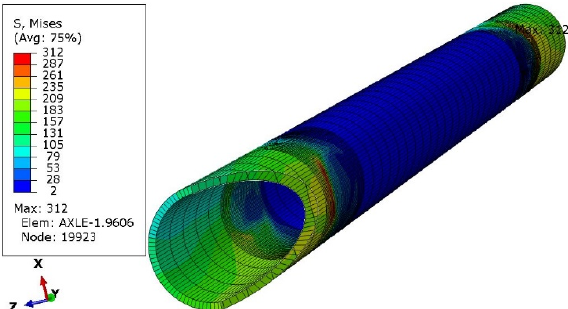
Figure 8. Stress distribution in the axle while only left wheel break is active.